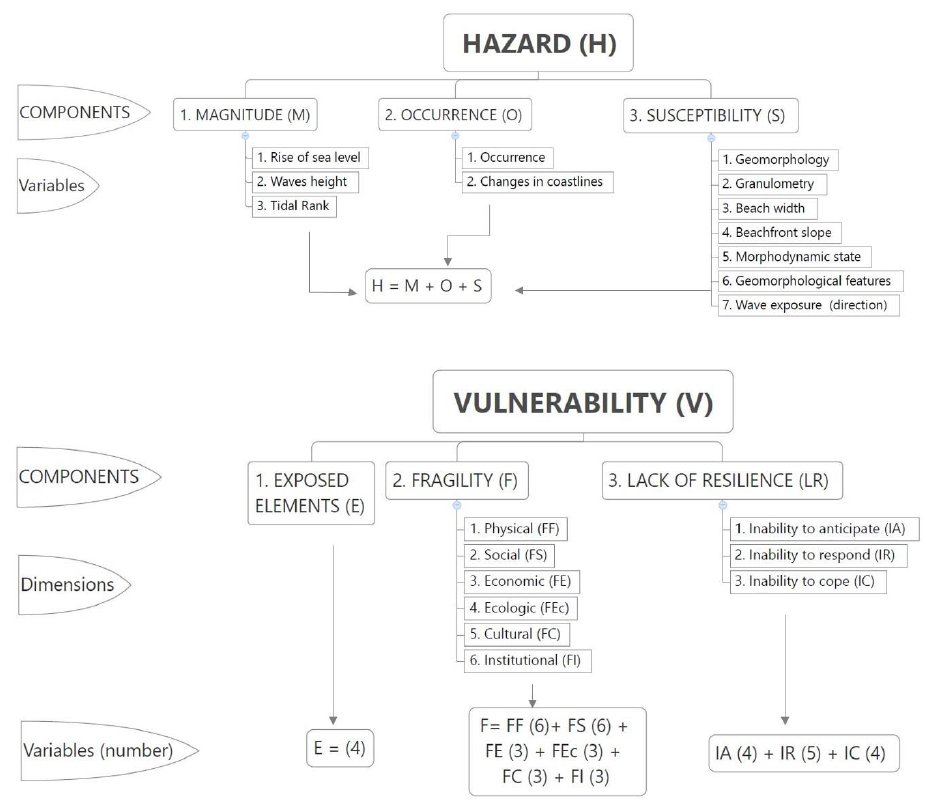
Figure 2. General methodological framework of hazard and vulnerability assessment for coastal erosion. Hazard is shown with its 3 components (1. Magnitude, 2. Occurrence, and 3. Susceptibility), the variables for each component, and the equation. Vulnerability is shown with its 3 components (1.